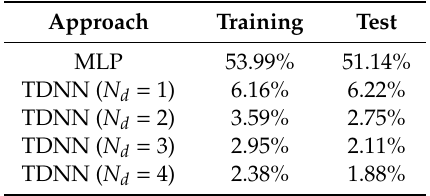
Table 3. Accuracy comparison of two modeling approach at di ff erent